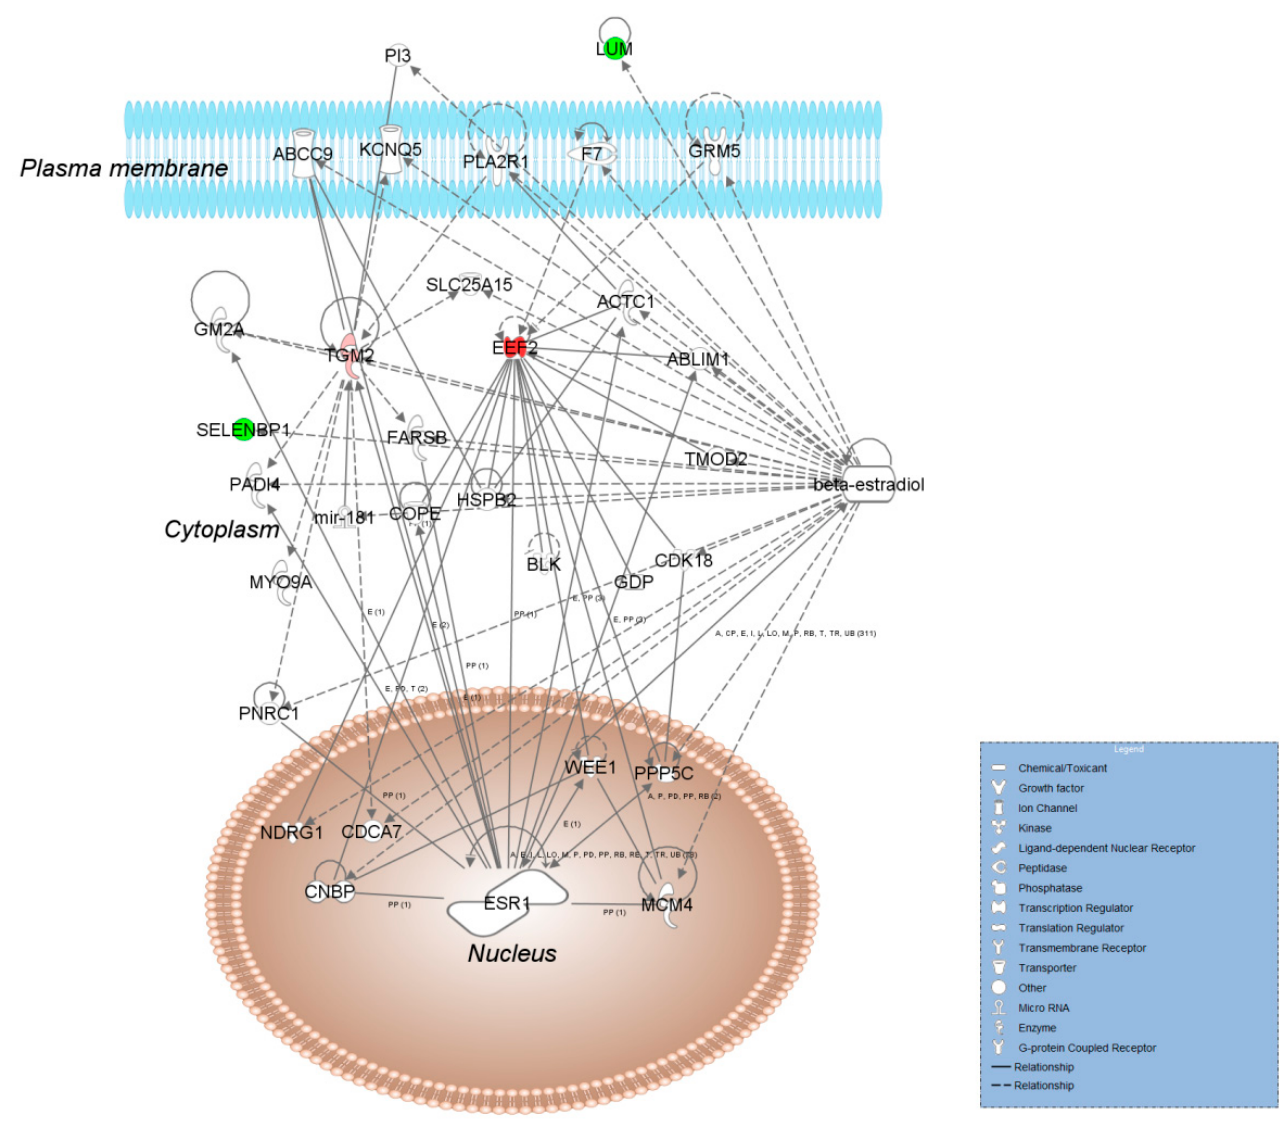
Figure 2. Molecular interaction Ingenuity Pathway Analysis (IPA ® ) network associated with connective tissue development and function, organ morphology, reproductive system development, and function assembled from the E 2 -regulated uterine proteins TGM2, elongation factor 2 (EEF2), selenium binding protein 1 (SELBP1), and lumican (LUM) in the rat. The shapes (see legend in the blue box) represent molecular classes of the regulated proteins. In the network, red and green colors denote upregulation and downregulation in response to E 2 treatment, respectively. The intensity of the color indicates the relative magnitude of fold change in protein expression pattern based on spectral counts. Solid and dashed lines represent direct and indirect interactions, respectively. Abbreviations: ABLIM1, actin binding LIM protein 1; ABCC9, adenosine triphosphate (ATP) binding cassette subfamily C member 9; ACTC1, actin alpha cardiac muscle 1; BLK, proto-oncogene, Src family tyrosine kinase; CDCA7, cell division cycle associated 7; CDK18, cyclin dependent kinase 18; CNBP, CCHC-type zinc finger nucleic acid binding protein; COPE, COPI coat complex epsilon; ESR1, estrogen receptor 1; F7, coagulation factor 7; FARSB, phenylalanyl–tRNA synthetase subunit beta; GDP, guanosine diphosphate; GM2A, ganglioside activator; GRM5, glutamate metabotropic receptor 5; HSPB2, heat shock protein family B (small) member 2; KCNQ5, potassium voltage-gated channel subfamily Q member 5; MCM4, minichromosome maintenance complex component 4; mir, microRNA; MYO9A, myosin IXa; NDRG1, N-myc downstream regulated 1; PADI4, peptidyl arginine deiminase 4; PI3, peptidase inhibitor 3; PLAZR1, phospholipase A2 receptor 1; PNRC1, proline rich nuclear receptor coactivator; PPPP5C, protein phosphatase 5 catalytic subunit; SLC25A15, solute carrier family 25 member 15; TMOD2, tropomodulin 2; WEE1, G2 checkpoint